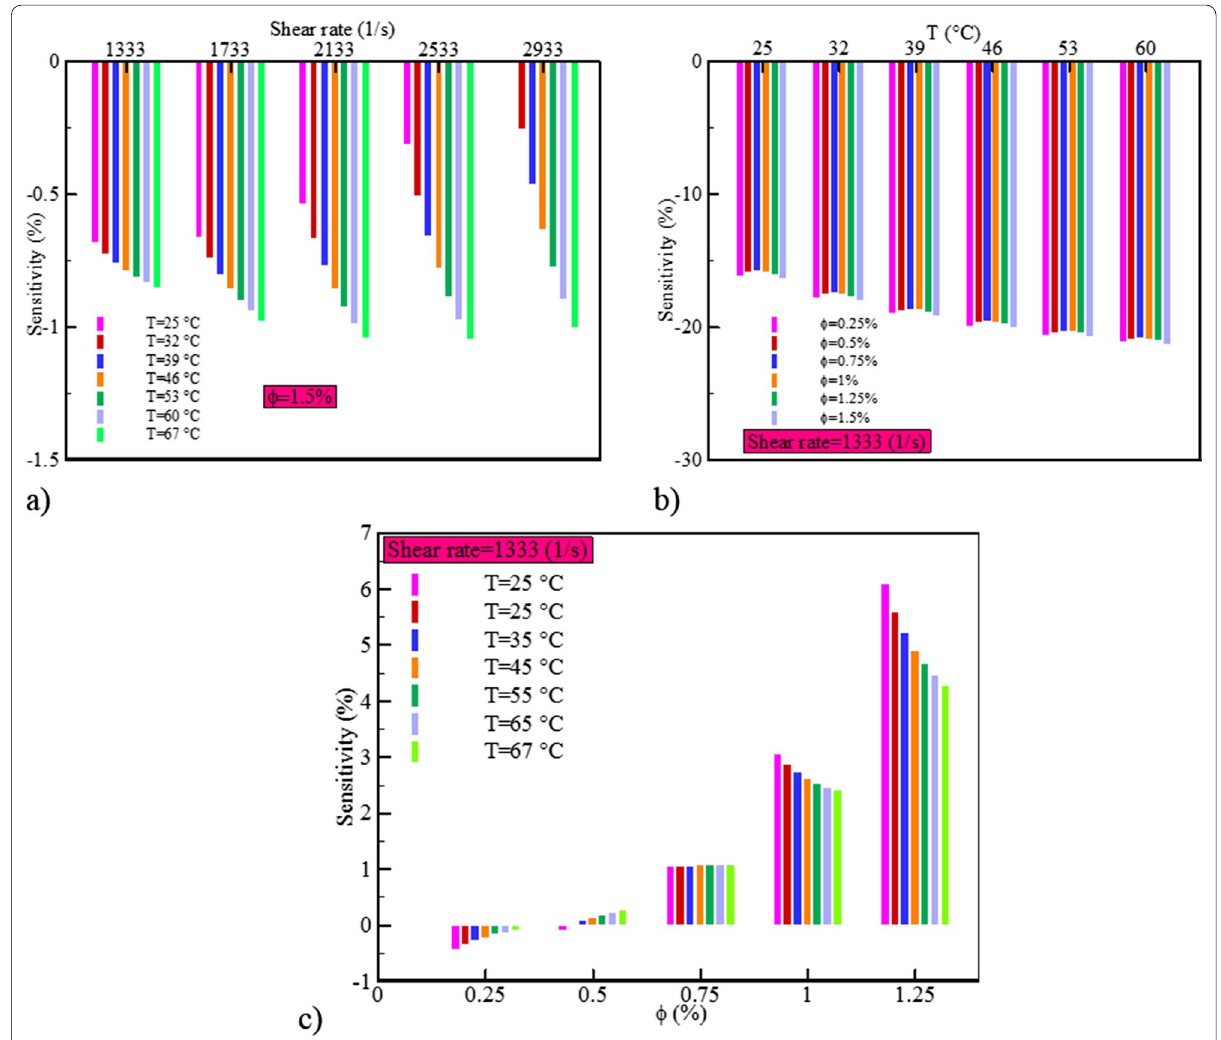
Fig. 21 Sensitivity analysis diagram for the cerium oxide–tin oxide/SAE50 hybrid